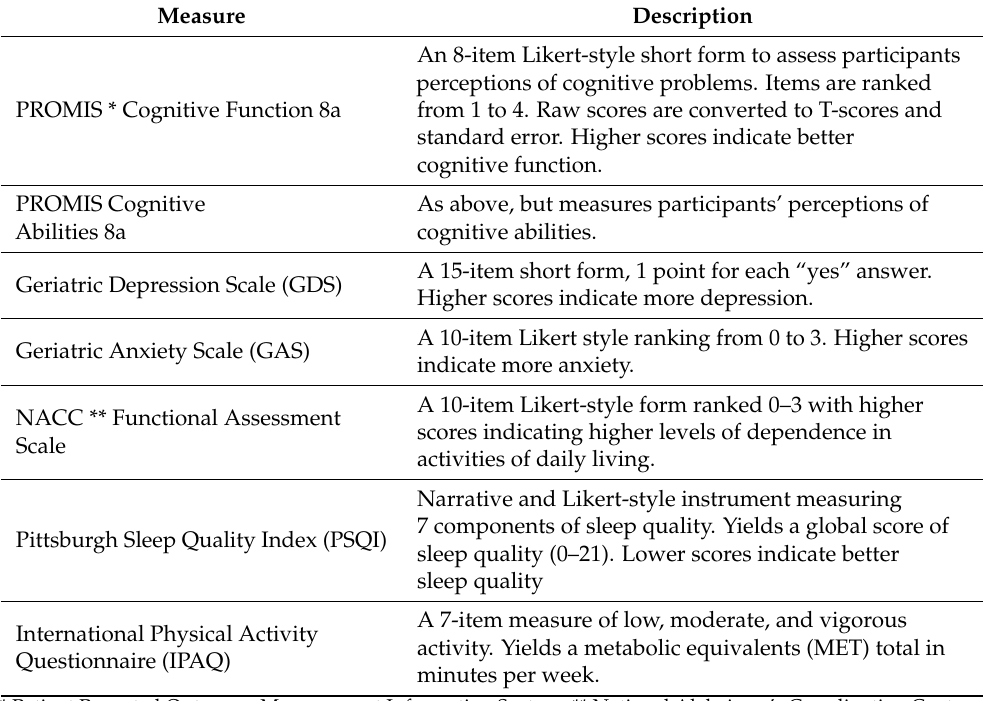
Table 2. Self-report